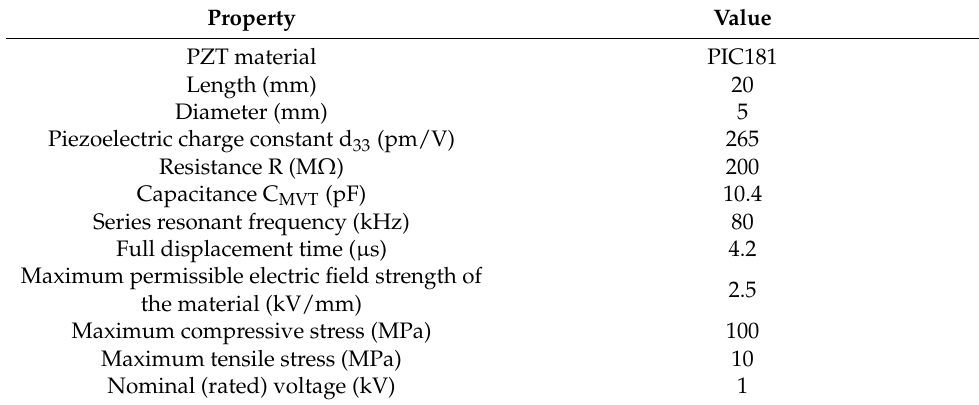
Table 1. Specifications of the MVT module